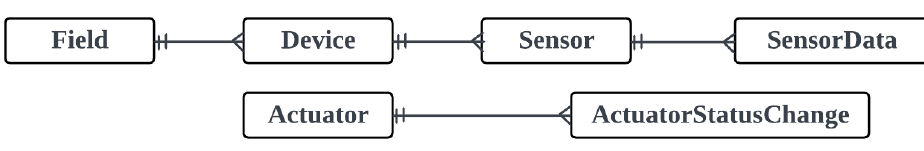
Figure 8. Data model implemented in the MongoDB database in the computing